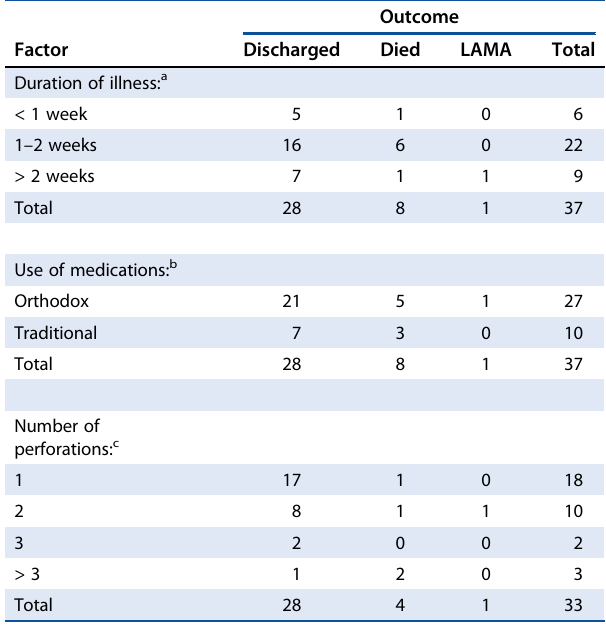
Table 6: Comparing the outcome with: the duration of illness; use and type of medication before presentation; and number of perforations